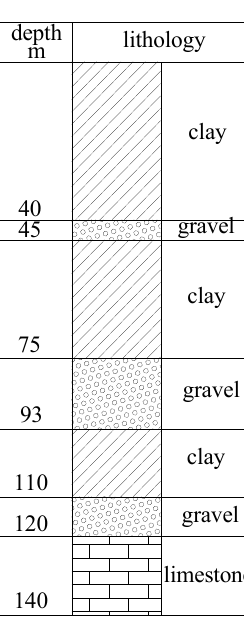
Figure 2. The profile of the borehole.